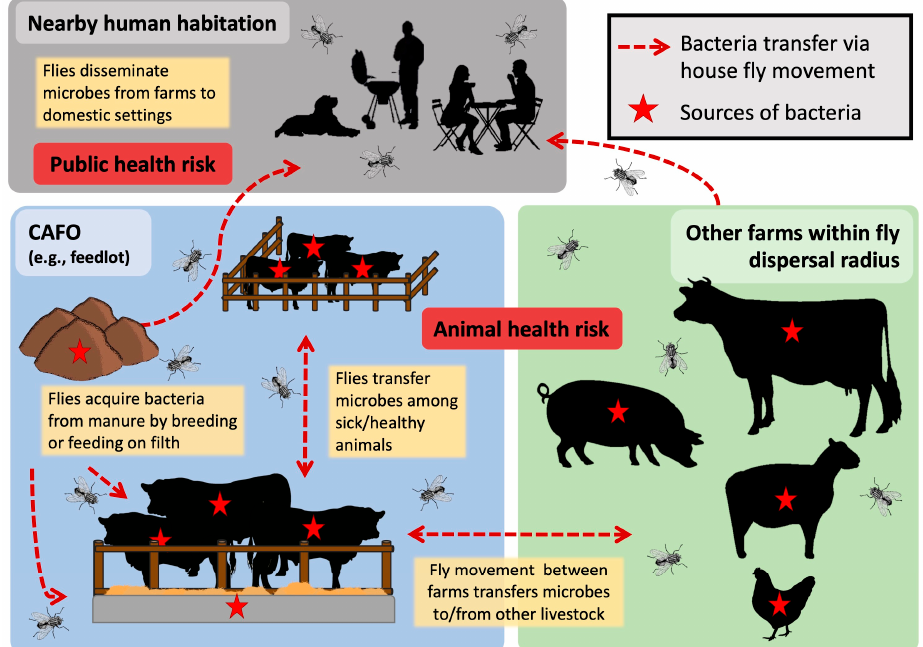
Figure 3. House flies pose a risk to human and animal health by disseminating and transmitting microbes. House flies acquire microbes such as bacteria from sources such as animals and their waste, and disseminate within and among farms, as well as to nearby areas of human habitation.